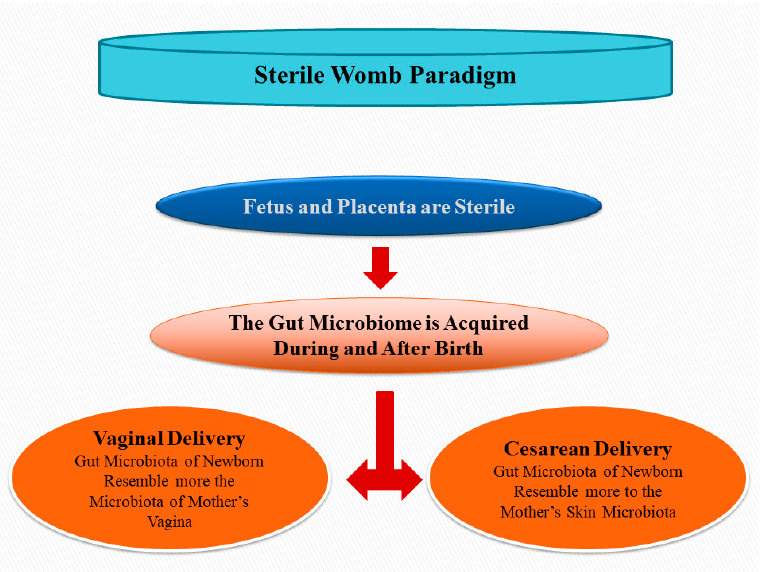
Figure 1. In the sterile womb paradigm, the placenta, amniotic fluid, and the gut of fetuses are not colonized by micro-organisms during pregnancy, and the intestinal microbiome of the newborn is acquired only during parturition and after the birth. Of note, the type of parturition affects early microbial colonization of the newborn.